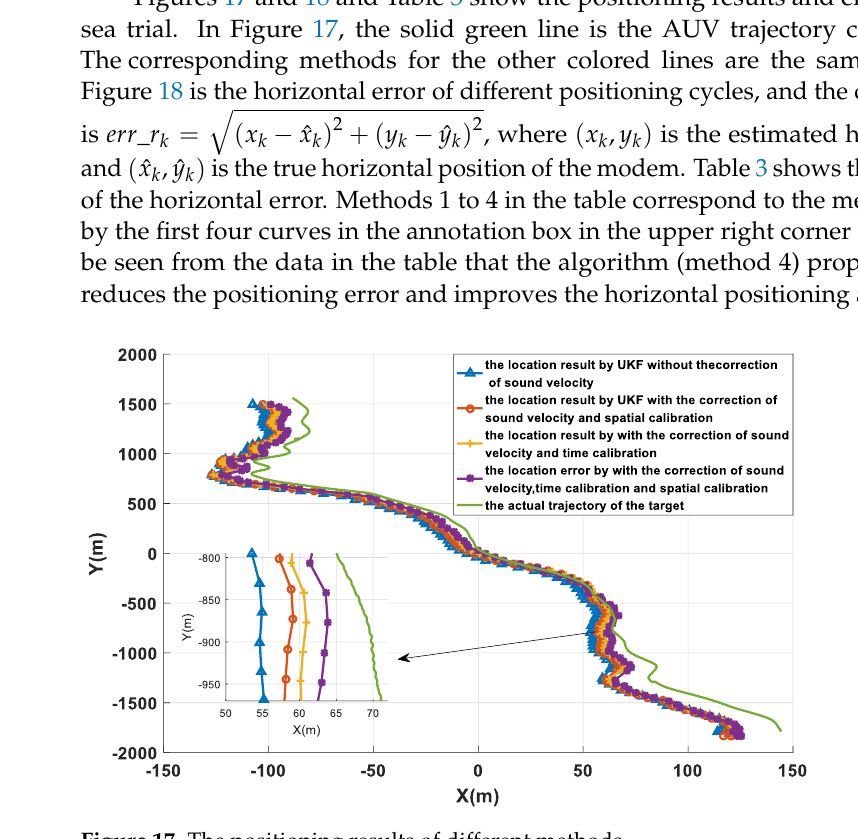
Figure 17. The positioning results of different methods.